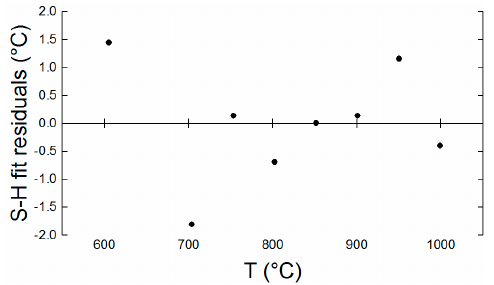
Figure 10. Residuals of the Sakuma-Hattori fit. These values are significantly smaller than the uncertainty of each of the measurement points. The standard error for these data is 1.03 °C